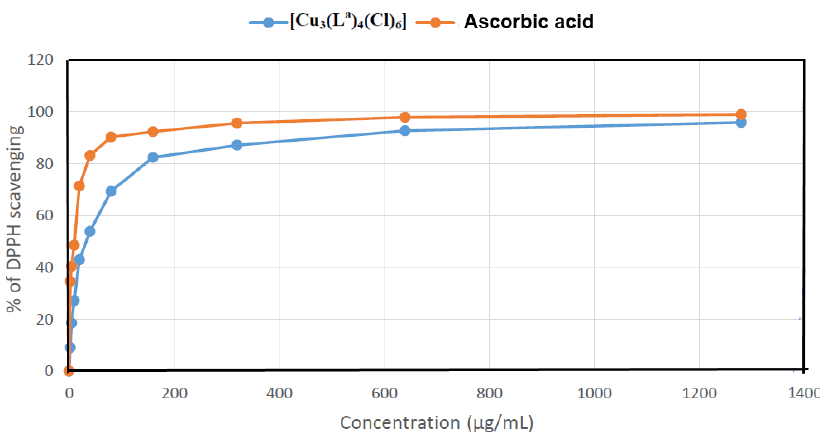
Figure 8. The antioxidant activity of the Cu(II) complex using DPPH assay.